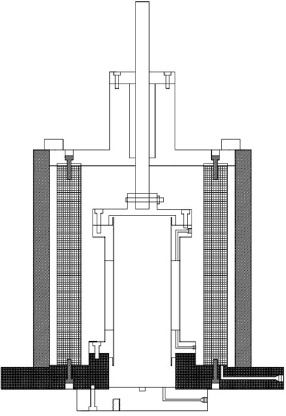
Figure 5. Schematic diagram of the cyclic hollow cylinder test device at the University of Colorado at Denver Geotechnical Laboratory.